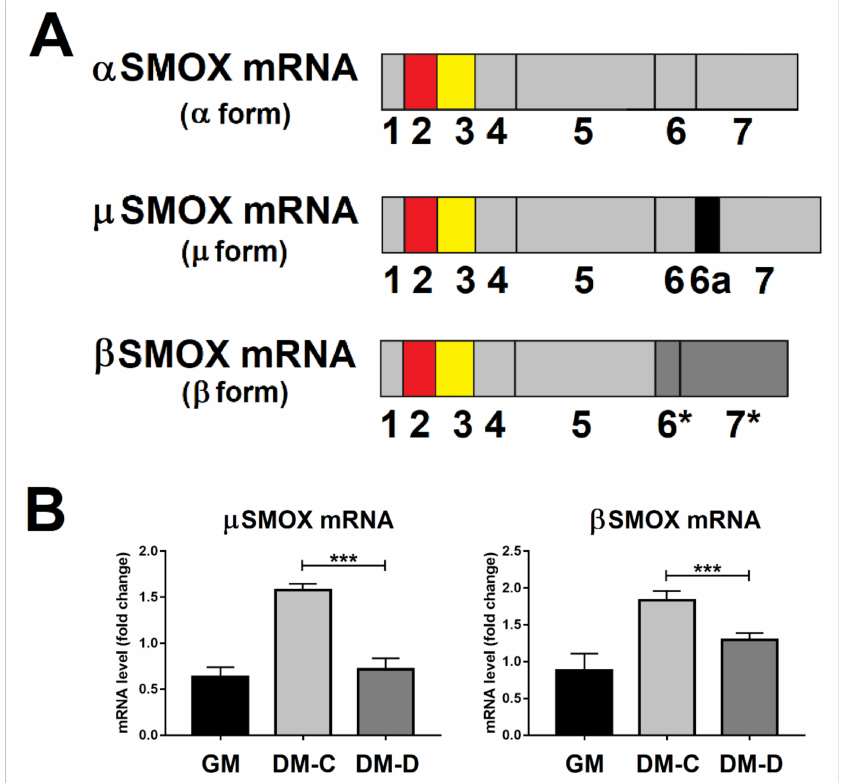
Figure 6. SMOX RNA transcript splicing variant levels in atrophic C2C12 cells. ( A ) Schematic representation of α , µ and β SMOX mRNA splicing variants. The second and third exons composing circSMOX RNA are highlighted in red and yellow respectively, common exons are in light grey, extra-exon present in the µ SMOX mRNA splicing variant, in light grey, extra-exon 6a present in the µ SMOX mRNA splicing variant, in dark grey, out of frame exons present in the β SMOX mRNA splicing variant. ( B ) qRT-PCR of µ and β SMOX mRNA splicing variants from GM, DM-C and DM-D. Data are calculated relative to the internal housekeeping gene (GAPDH) and are expressed as the mean fold change compared with GM control. Each value represents the mean ± SD of three independent experiments, each performed in triplicate. One-way ANOVA, followed by Bonferroni’s test, were used to determine significant di ff erences *** p < 0.001 compared to GM